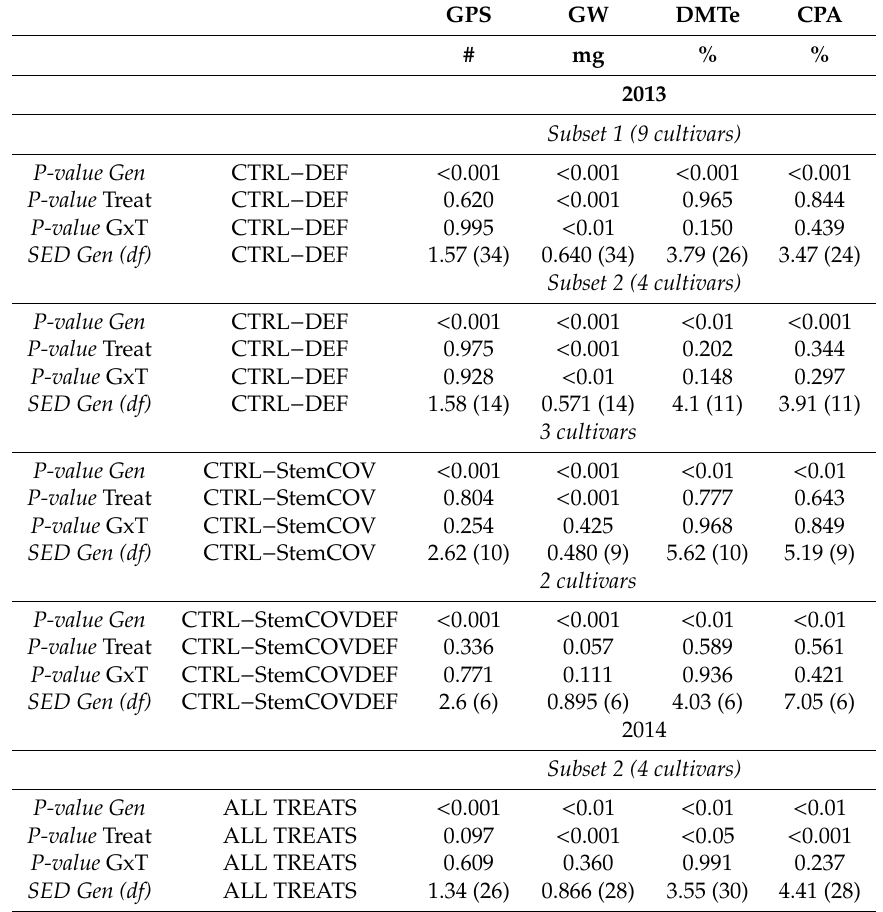
Table 2. Analysis of variance for grain weight (GW), grains per spike (GPS), DM translocation e ffi ciency (DMTe) and contribution of pre-anthesis reserves to grain weight (CPA, %) in control and manipulated shoots for individual